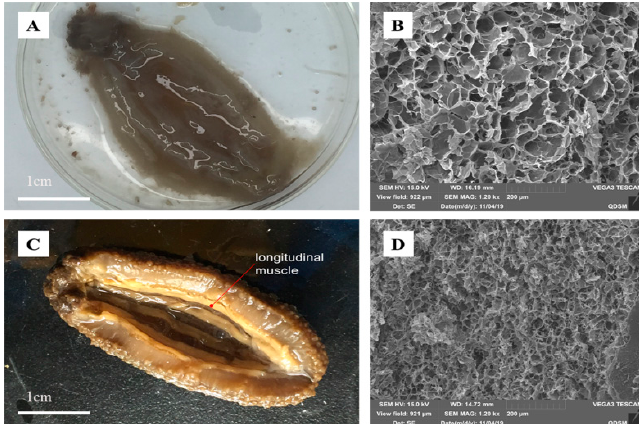
Figure 3. Appearance and SEM images of the uncrosslinked and oxidized sucrose crosslinked high-temperature-treated (HTT) rehydrated sea cucumbers. ( A ) Appearance of the uncrosslinked. ( B ) SEM image of the uncrosslinked. ( C ) The appearance of the crosslinked. ( D ) SEM image of the crosslinked.